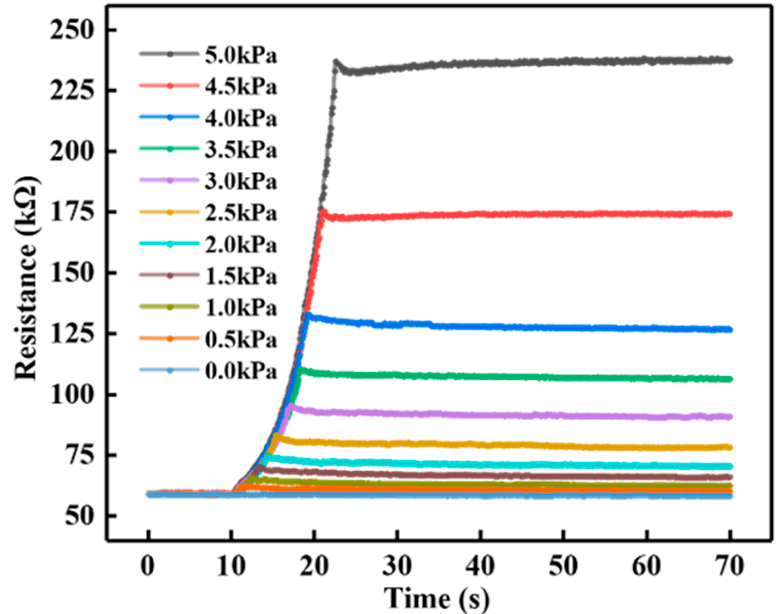
Figure 8. The resistance of the lower electrode of the SHEPA under different pressures, in which the pressurization rate is 0.5 kPa/s.